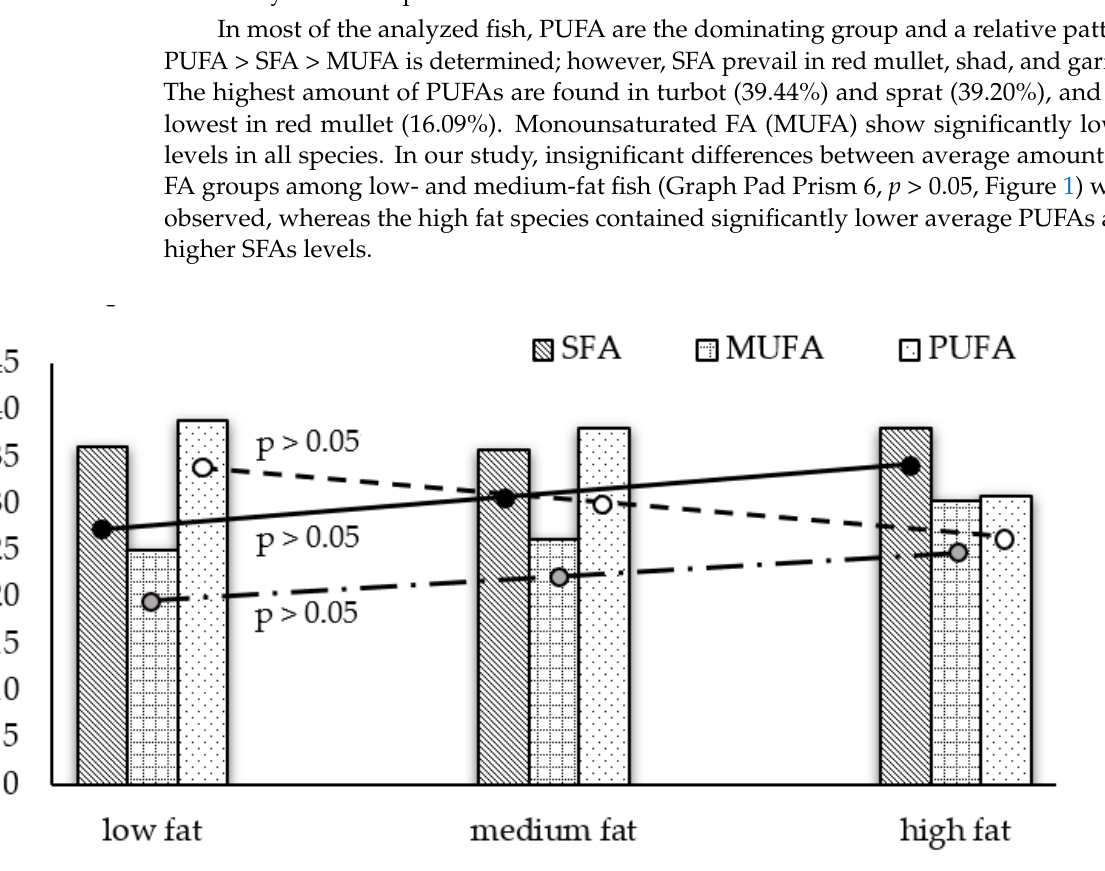
Figure 1. Differences in average fatty acid groups among the analyzed fish species with different lipid content. It is known that marine fish are very good sources of PUFAs [4], which is confirmed by the presented results. When comparing the fatty acid profiles of species with varying lipid content, a negative relationship between TL and PUFA content was found in fish with TL < 5%; and a positive correlation between TL and SFA levels in high-fat fish (Figure